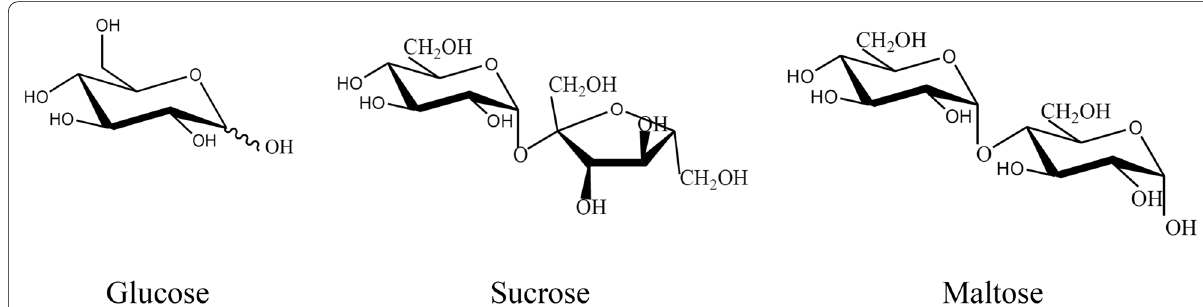
Fig. 2 Molecular structure of sugars used to form the alcohol/sugar